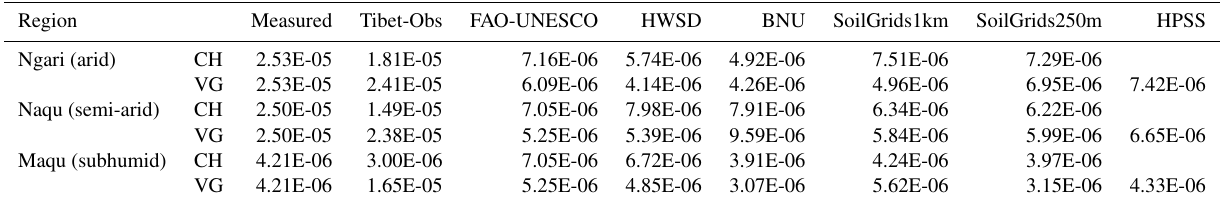
Table 4. Comparisons of mean derived K s from the applicable PTFs for the CH and VG models based on various soil datasets, with the measurements. The unit of listed value is ms − 1 . Region Measured Tibet-Obs FAO-UNESCO HWSD BNU SoilGrids1km SoilGrids250m HPSS Ngari (arid) CH Naqu (semi-arid)